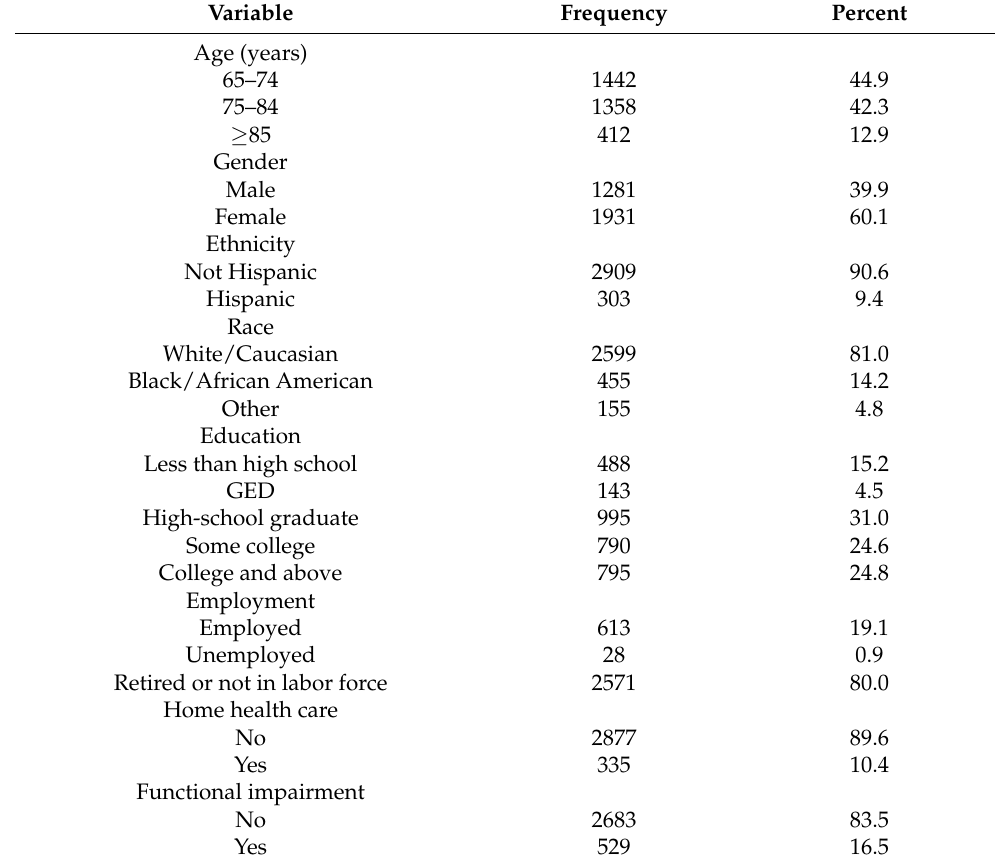
Table 2. Frequencies and Percentages for Categorical